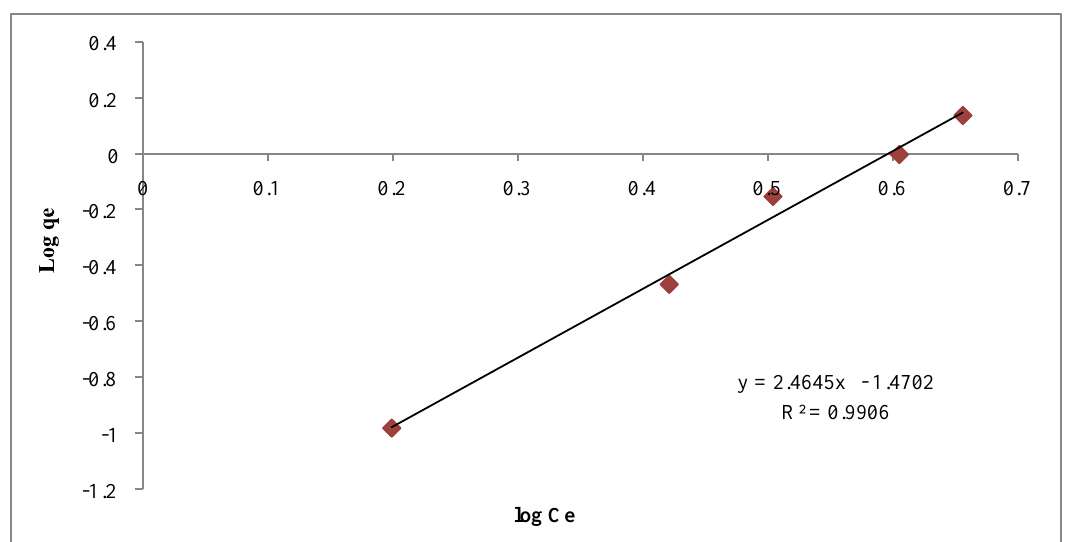
Figure 6. Freundlich isotherm peanut shell